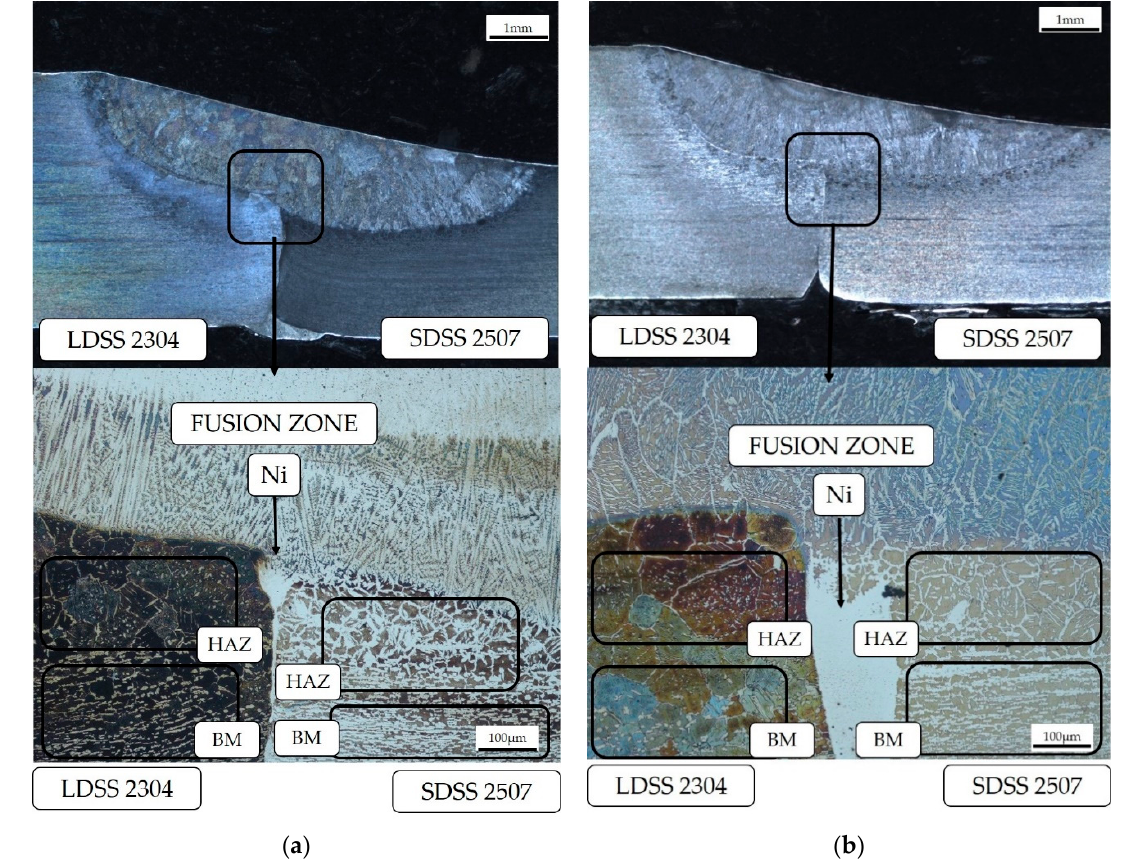
Figure 4. Welded zones by optical microscope to 10 ×: ( a ) Test #3 and ( b ) Test #1.